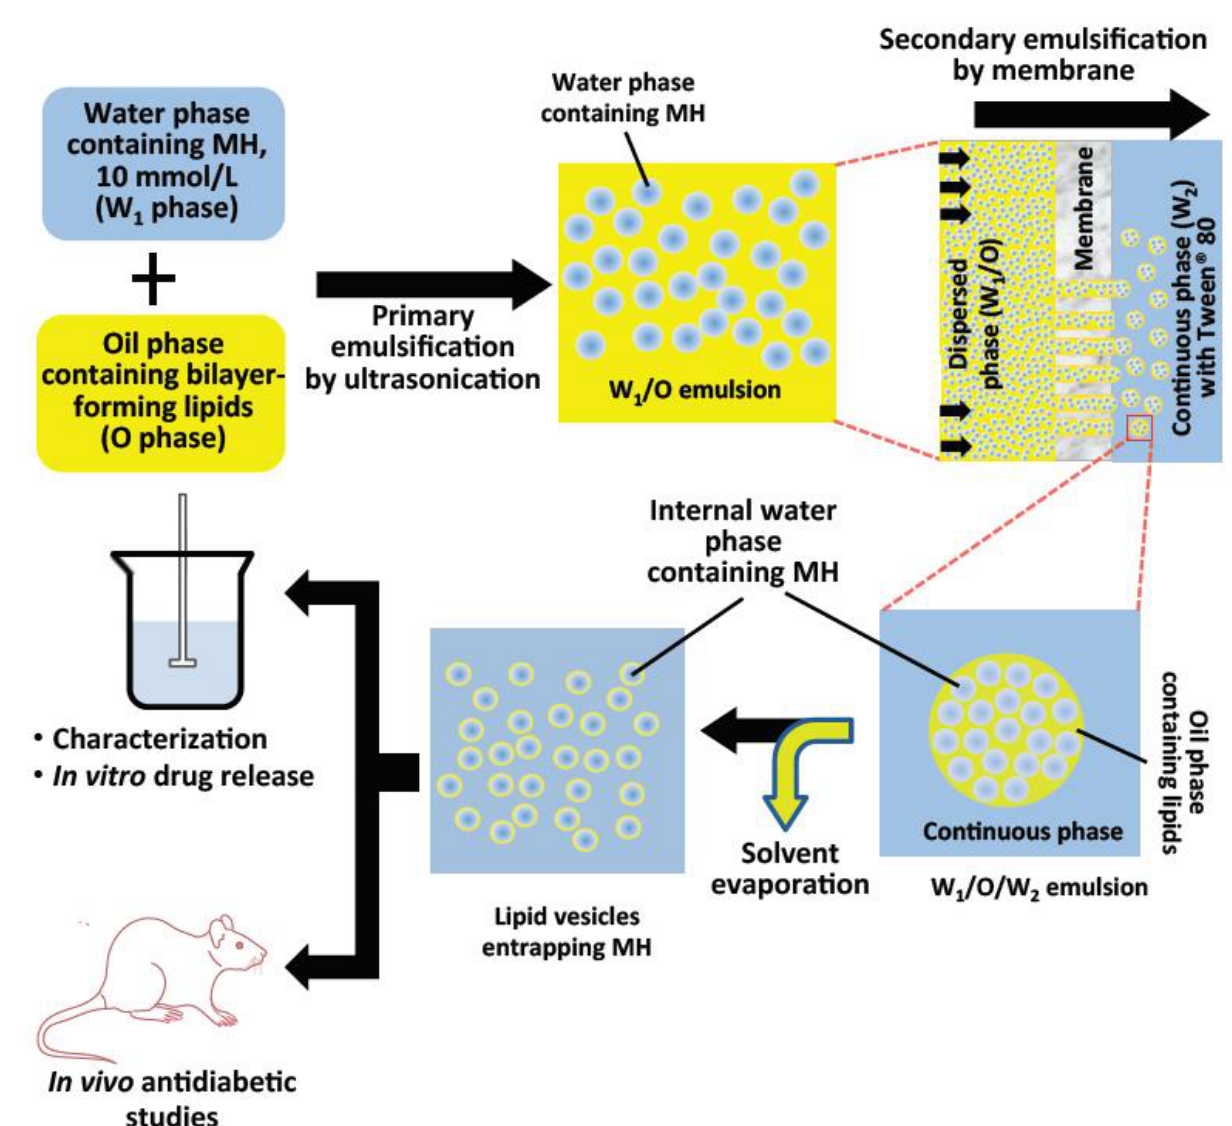
Figure 6. Schematic presentation of the method for the formulation of lipid vesicles encapsulating metformin hydrochloride and the in vitro and in vivo